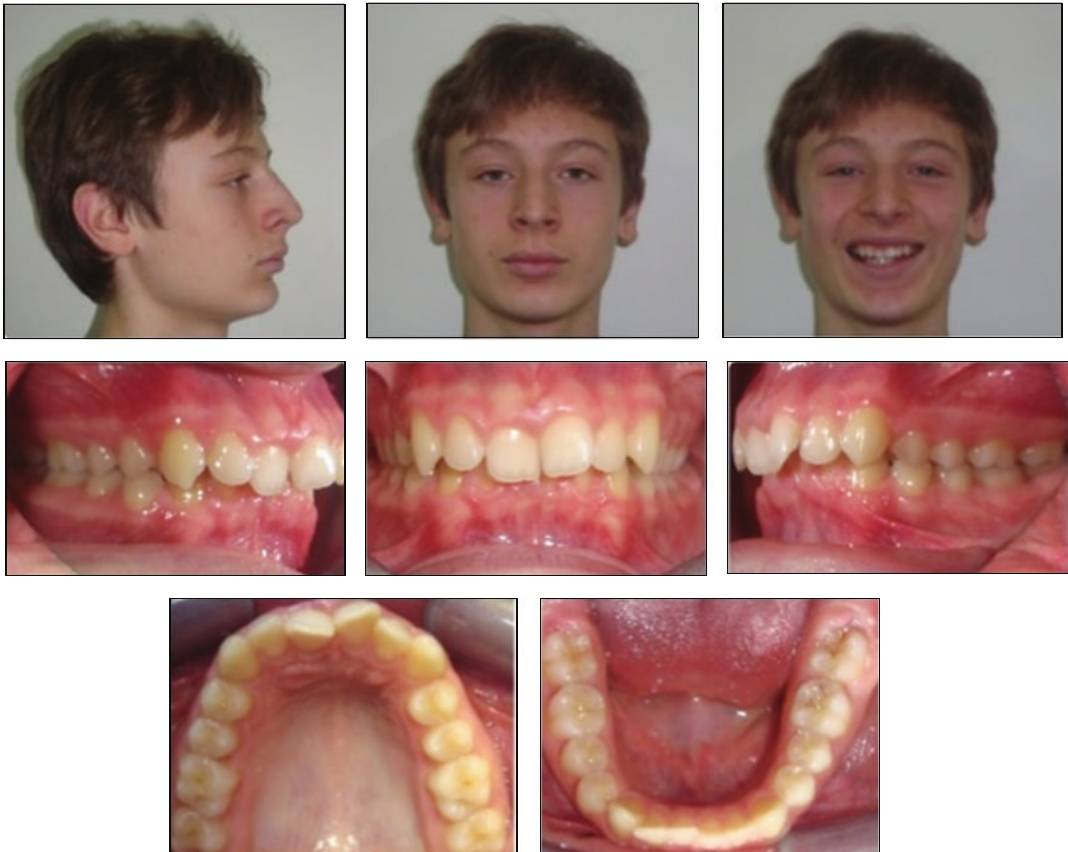
Figure 1: Pretreatment facial and intraoral